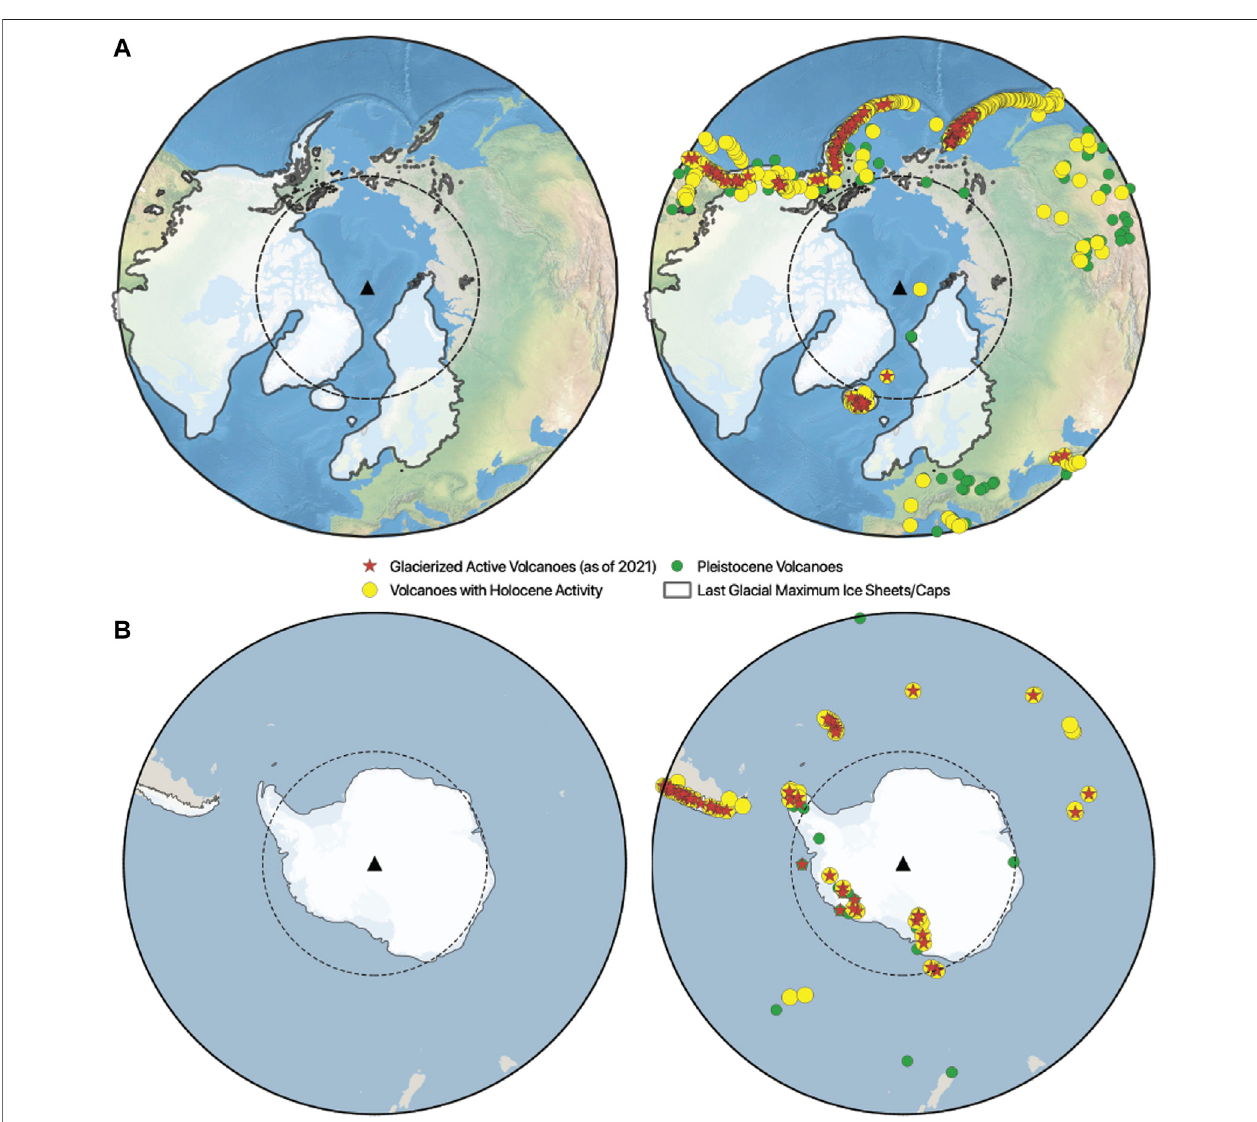
FIGURE 1 | Global maps showing estimates of the extents of ice sheets and ice caps at the Last Glacial Maximum (Gowan, 2019) and distributions of glacierized (Edwards et al., 2020),Holocene and Pleistocenevolcanoes (fromthe SmithsonianGlobalVolcanism Program). (A) Ice conditions and volcanoesfrom 40 ° north latitude to the North Pole. (B) Ice conditions and volcanoes from 40 ° south latitude to the South Pole.